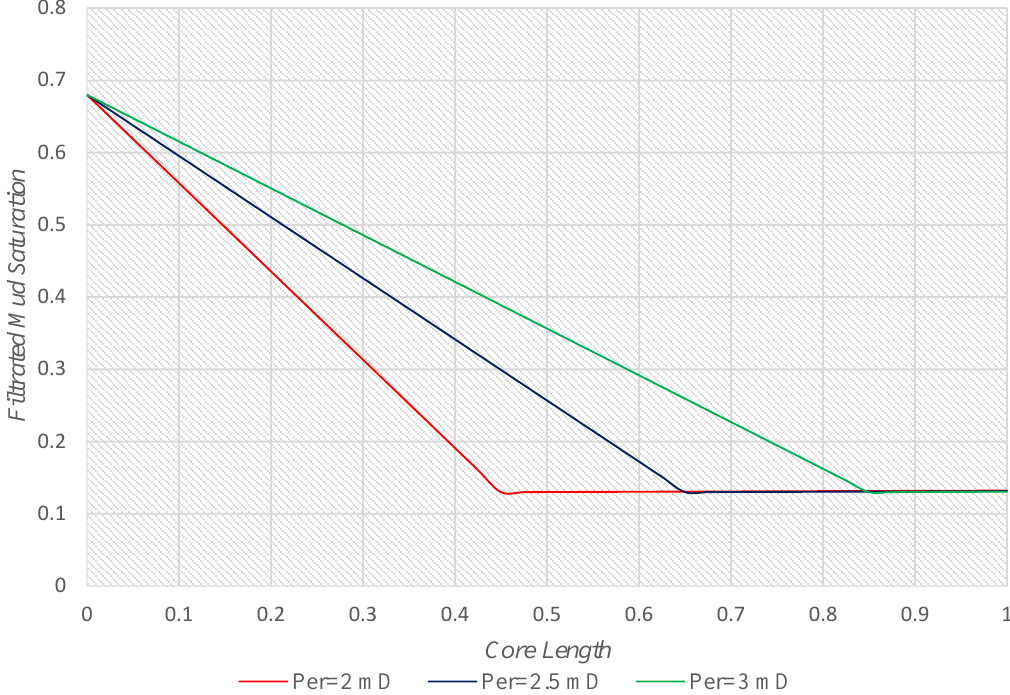
Figure 2. Permeability Effect on the filtrated mud saturation.